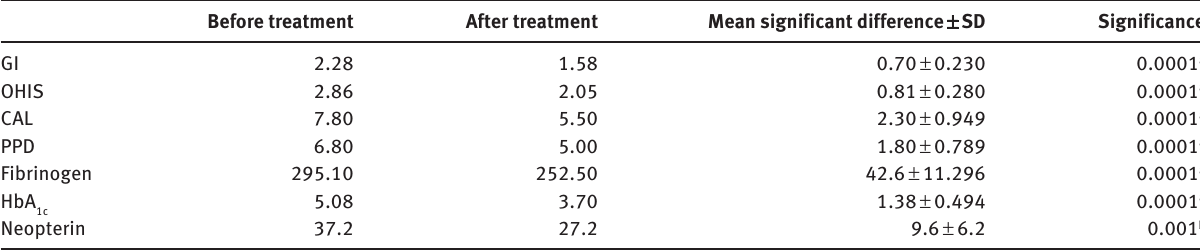
Table 2: Intragroup comparison of all variables before and after treatment in group CP.